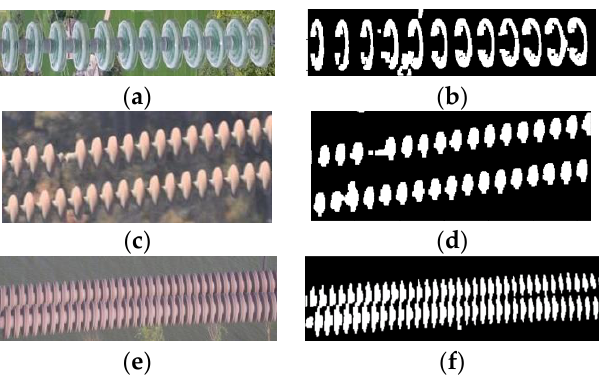
Figure 10. Segmentation effects of different types of insulators . ( a ) Glass insulators, ( b ) binary image of glass insulators, ( c ) porcelain insulators 1, ( d ) binary image of porcelain insulators 1, ( e ) porcelain insulators 2, ( f ) binary image of porcelain insulators 2.